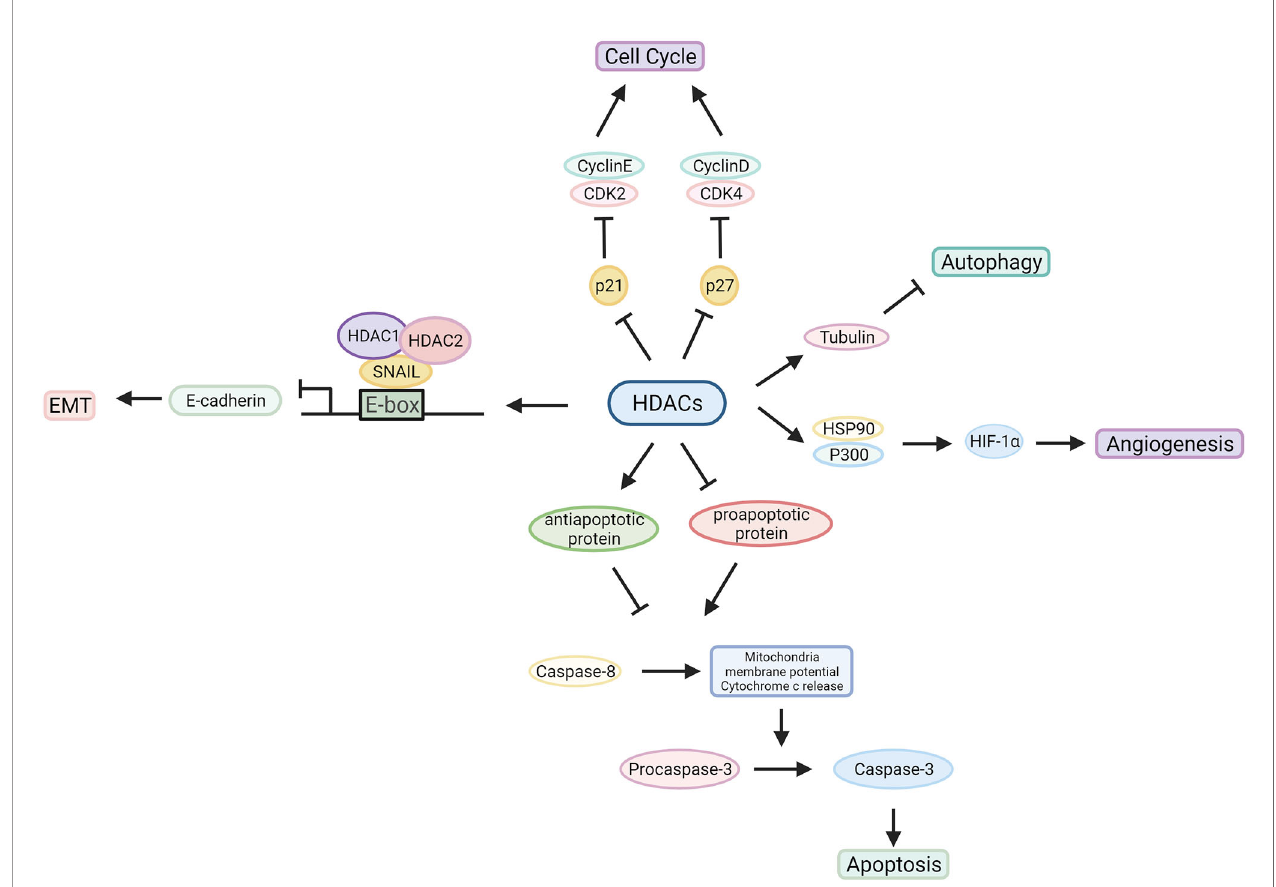
FIGURE 4 | Characterized mechanism of HDACs in cancer development. HDACs in fl uence the tumorigenic process by regulating oncogene and tumour suppressor gene expression or interacting with related